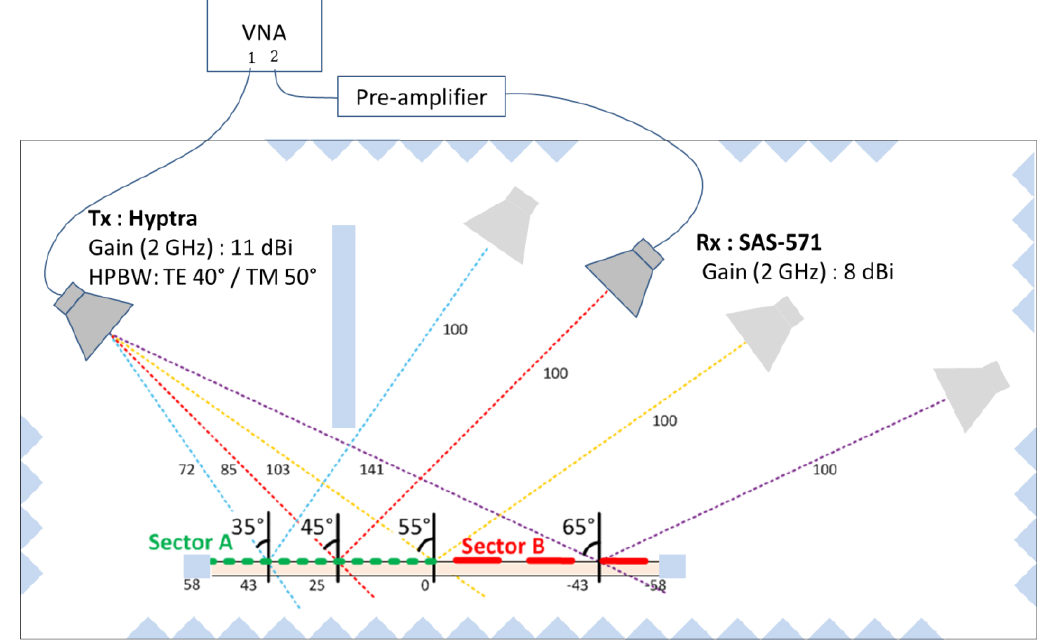
Figure 8. Bistatic measurement setup in anechoic chamber. Each sector was illuminated with the proper angle range. The Tx antenna was static while the Rx antenna was moved for each angle of interest.